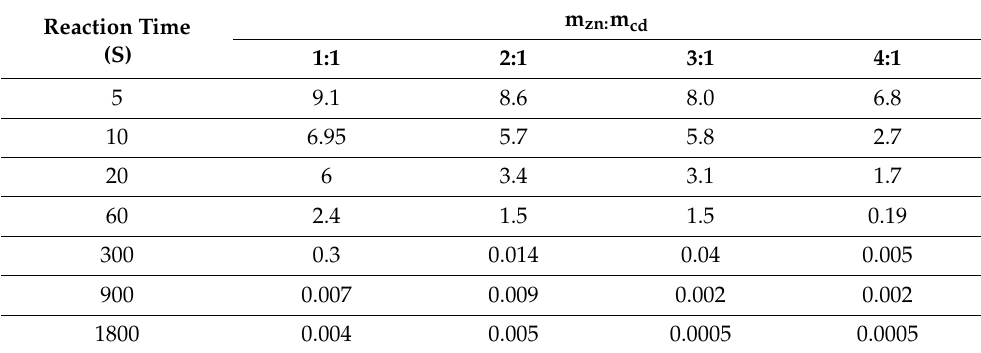
Table 4. Cd 2+ concentration (g/L) in solution with different zinc powder dosages and reaction times. Reaction Time